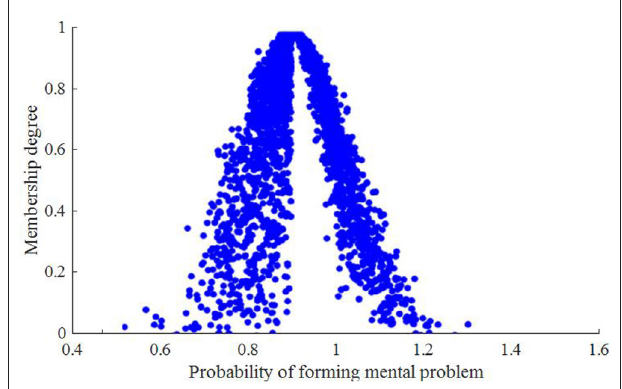
FIGURE 2 | Distribution of mental health indexes of community workers involved in the prevention of COVID-19 epidemic.